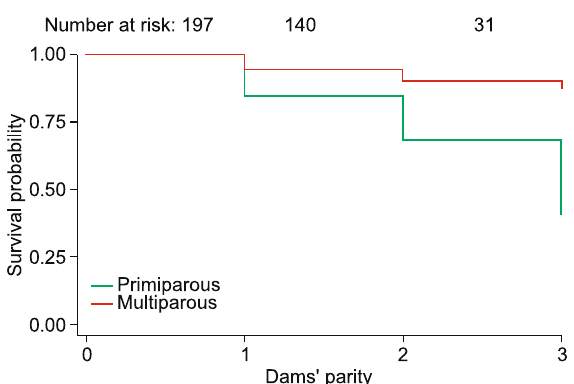
Fig. 2 K-M survival curve of all-cause mortality in lamb based on Dams’